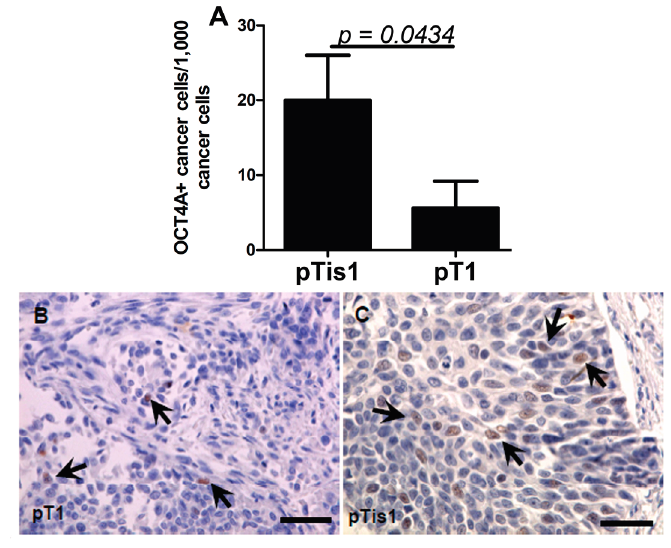
Figure 3. Mean low OCT4A level ( A ) in non-muscle invasive cancers without a coexisting in situ component ( B ) and with that component ( C ). Significant differences are denoted by p -values ( t -test). Arrows show OCT4A-positive nuclei (visualized with DAB and counterstained with hematoxylin); scale bars: 50 μ